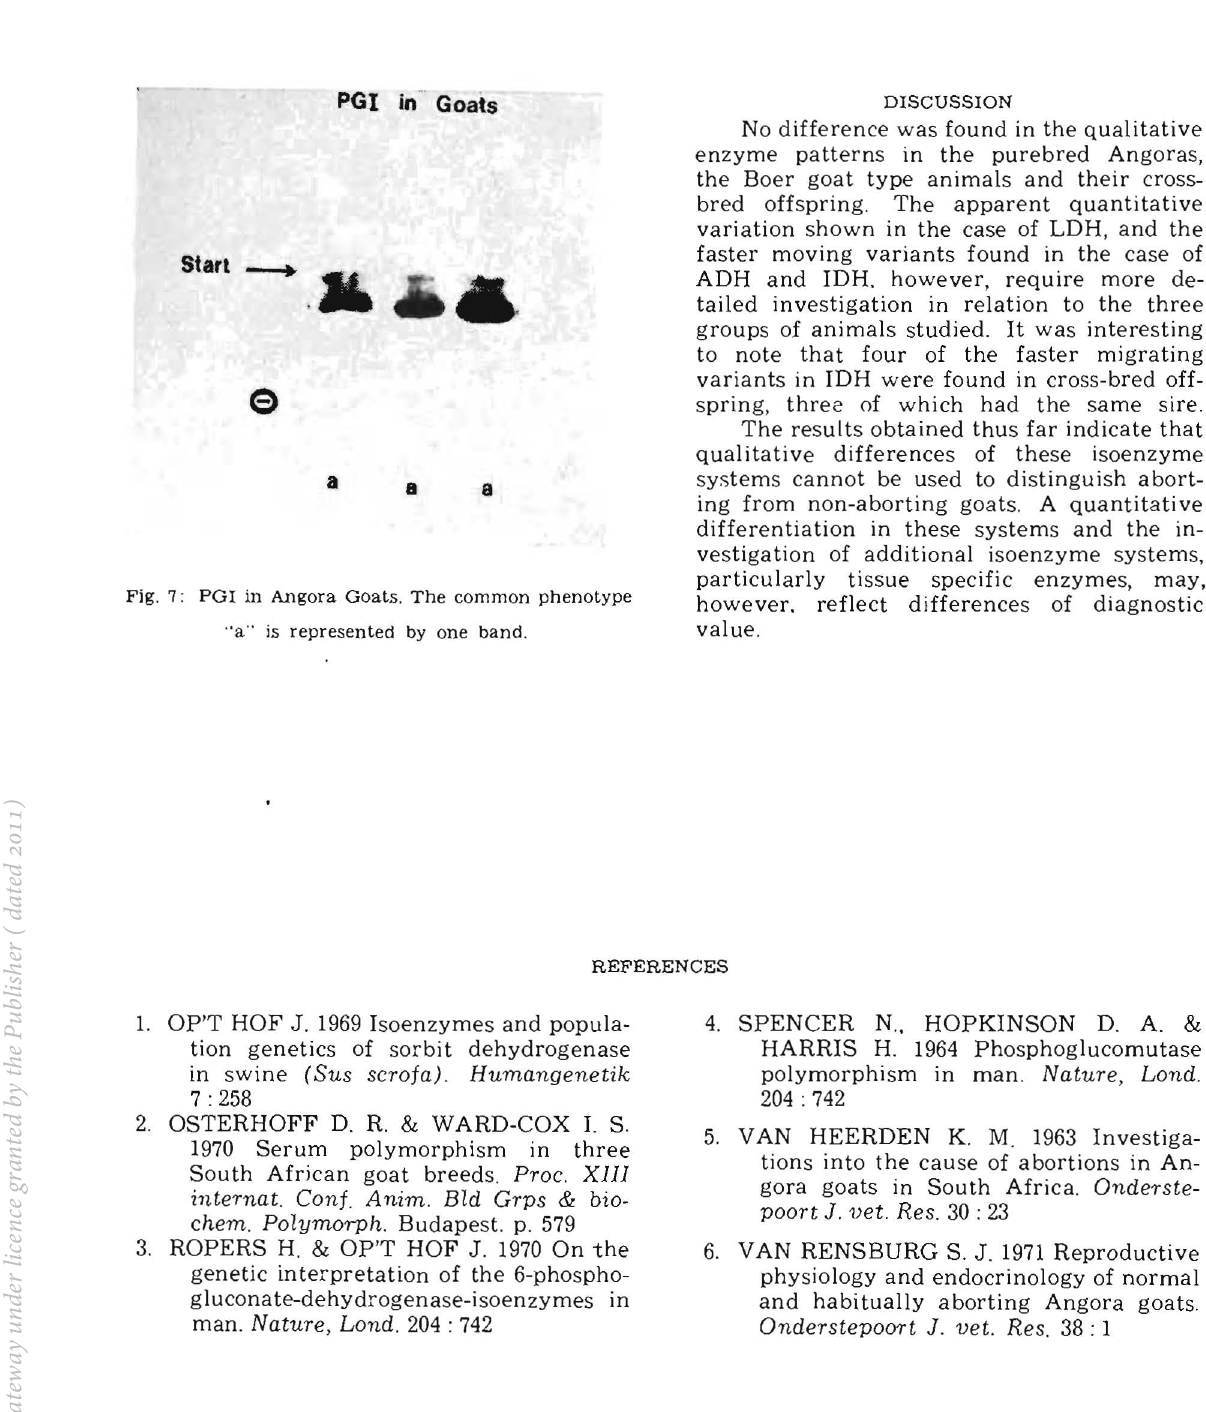
Fig. 7: PGI in Angora Goats. The common phenotype "a" is represented by one